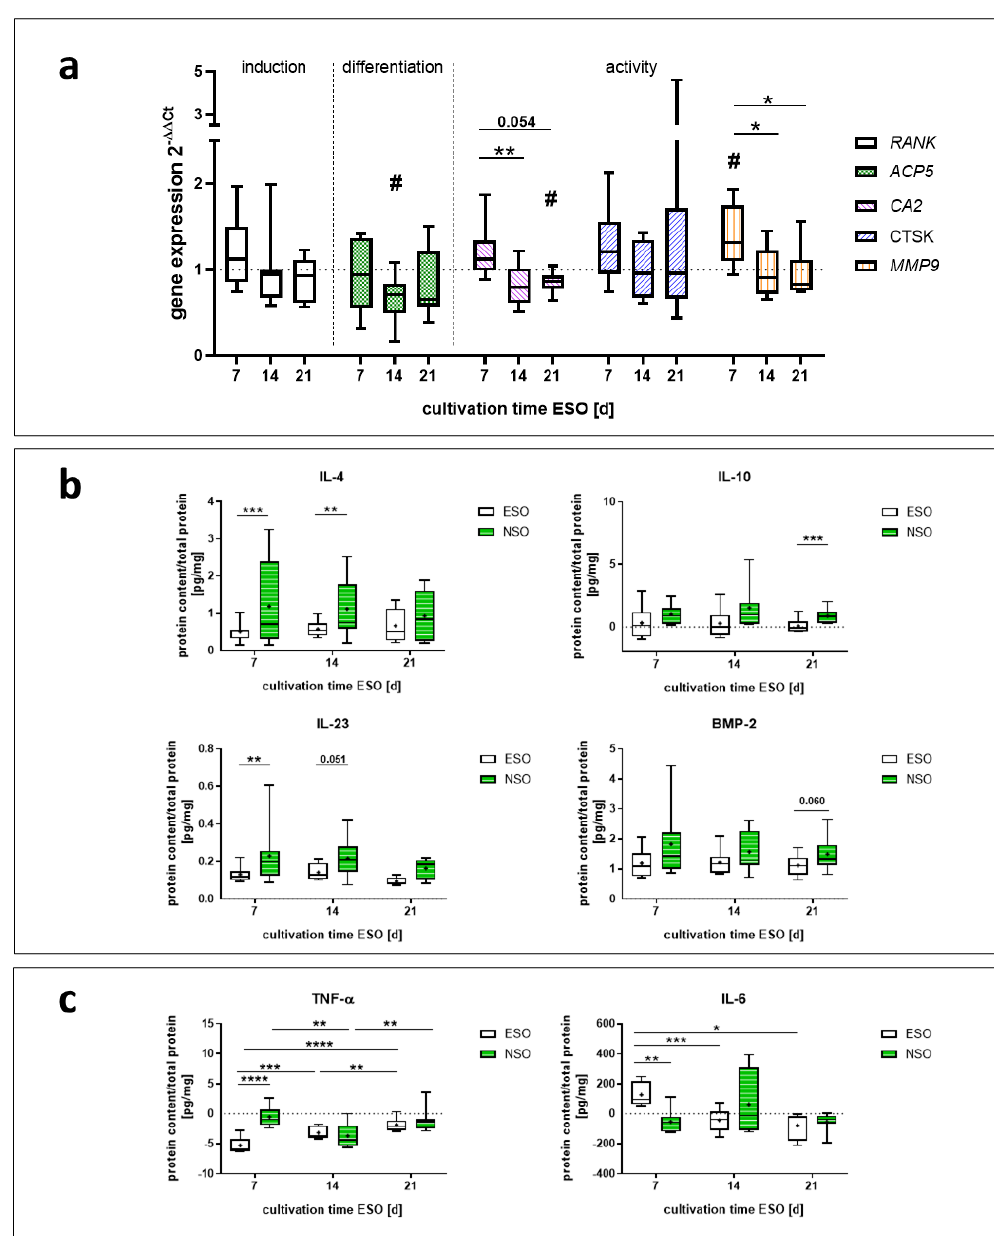
Figure 6. Gene expression and protein data of pre-osteoclasts after 48 h incubation with pooled supernatant of osteoblast (ESO) stimulated over 7, 14, and 21 d and without electric stimulation (NSO). ( a ) Gene expression data were related to the NSO using the 2 − ∆∆ Ct method. Boxplots are used to present the distribution of the total results with significant changes [n = 8]. Significant differences were determined using the two-way ANOVA with Tukey. # indicates significant differences between the ESO and NSO: # p < 0.05. * indicates significant differences between stimulation time points: * p <0.05. ( b , c ) Protein concentration related to the total protein concentration of the supernatant. The respective protein concentration from the control iwc was subtracted. Boxplots are used to present the distribution of the total results [n ≥ 6]. Significant differences were determined using the two- way ANOVA with Tukey. * indicates significant differences: * p < 0.05, ** p < 0.01, *** p < 0.001, **** p < 0.0001. ( b ) Proteins that were produced by the pre-osteoclasts ( c ) proteins that were consumed by the